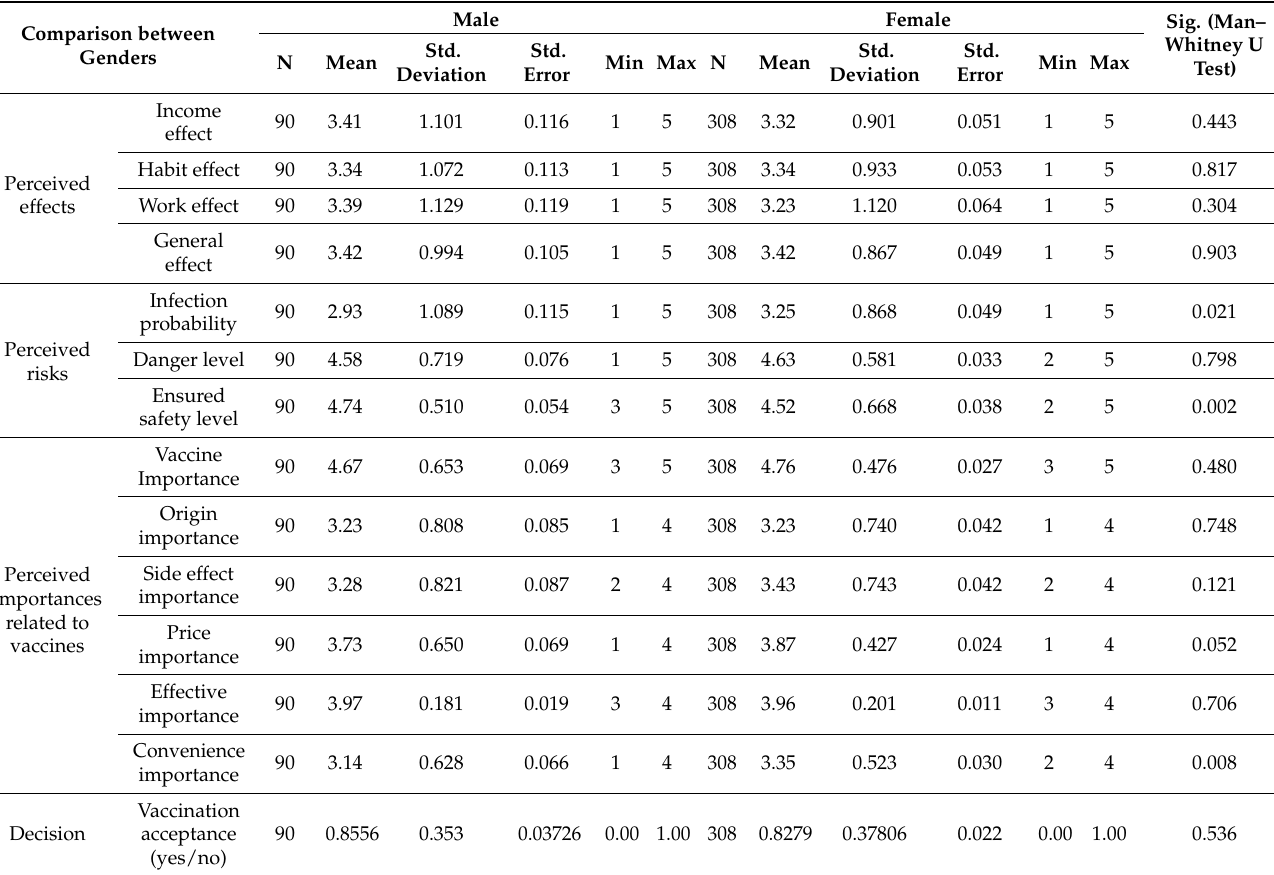
Table 4. Differences in perception and decision between two